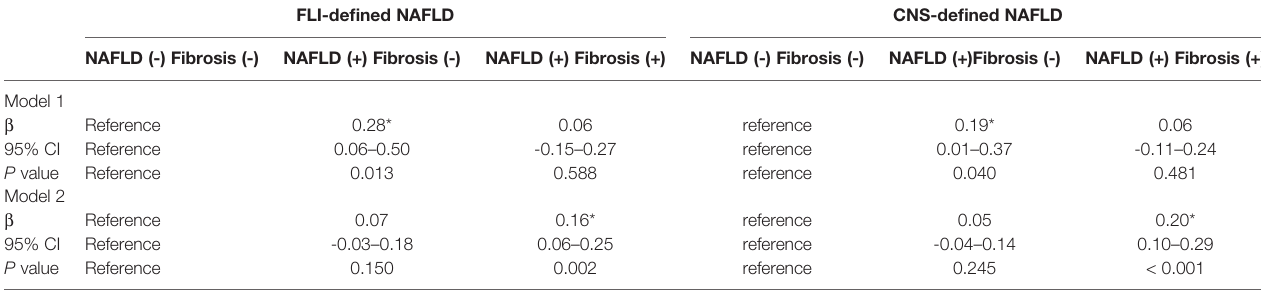
TABLE 2 | Association between NAFLD with FIB-4 – de fi ned liver fi brosis and 10-year major osteoporotic fracture probability in Korean men aged ≥ 50 years.